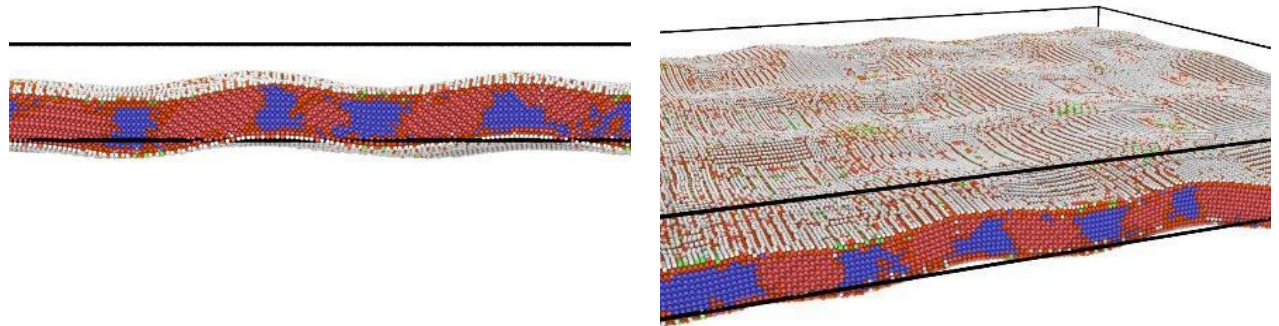
Figure 5. The formation of the TiNi martensite phase under cooling (down to T ⋍ 40 K) using the molecular dynamics method within the LAMMPS package. The rectangular simulation box shown is considered in the frameworks of the periodic boundary conditions applied in the x-y plane, and finite boundary conditions utilized along the z -axis. Number of atoms in the system is 0.3 × 10 6 atoms. The blue color denotes austenite (B2), the red color corresponds to the martensite phase (B19`), and the white-green color corresponds to the atoms located on the surface and does not cor- respond to any of the bulk phases.